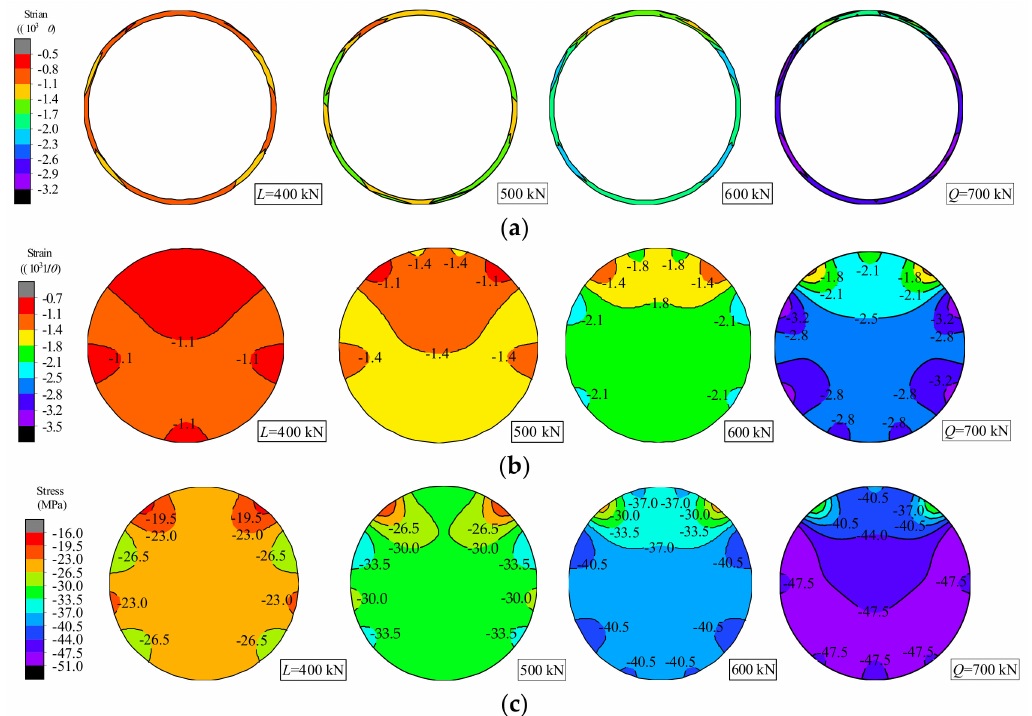
Figure 8. The strain and stress fields around characteristic loads L and Q : ( a ) The strain fields of steel tube around loads L and Q ; ( b ) the strain fields of core concrete around loads L and Q ; ( c ) the stress fields of steel tube around loads L and Q